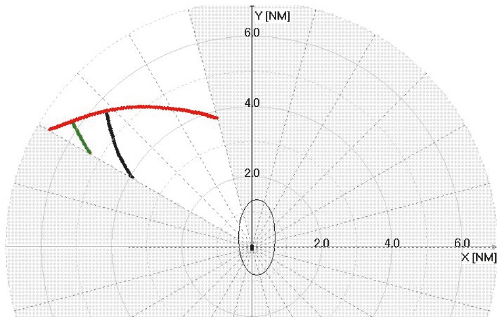
Figure 23: Action lines for stand-on crossing encounter with a target, whose true speed is 18 knots. Assumed are turns of 15 ∘ to starboard without speed reduction (red) or with speed reduced by 6 knots (green), and 9 knots (black).